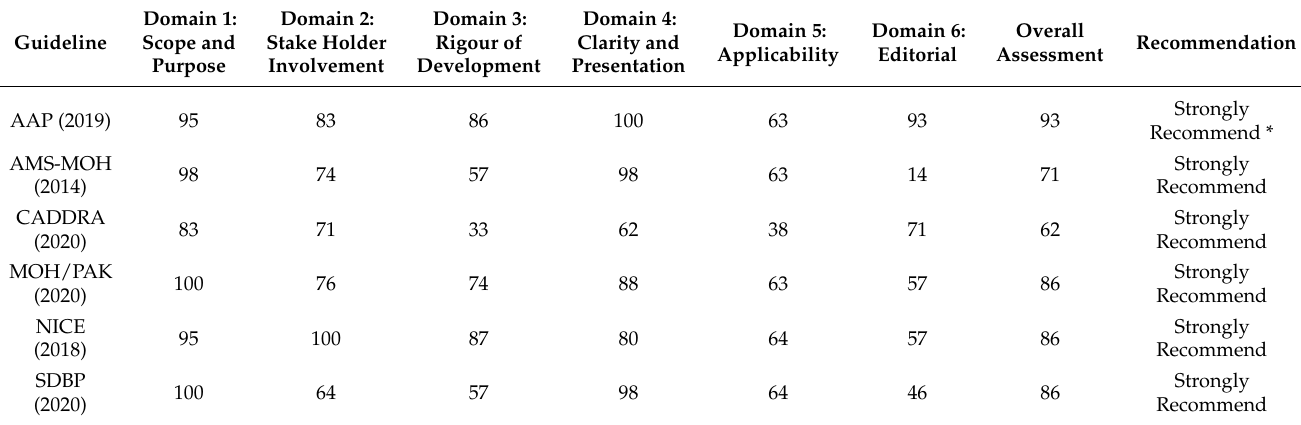
Table 3. Quality Analysis: AGREE II domain ratings and overall recommendations for clinical practice guidelines.